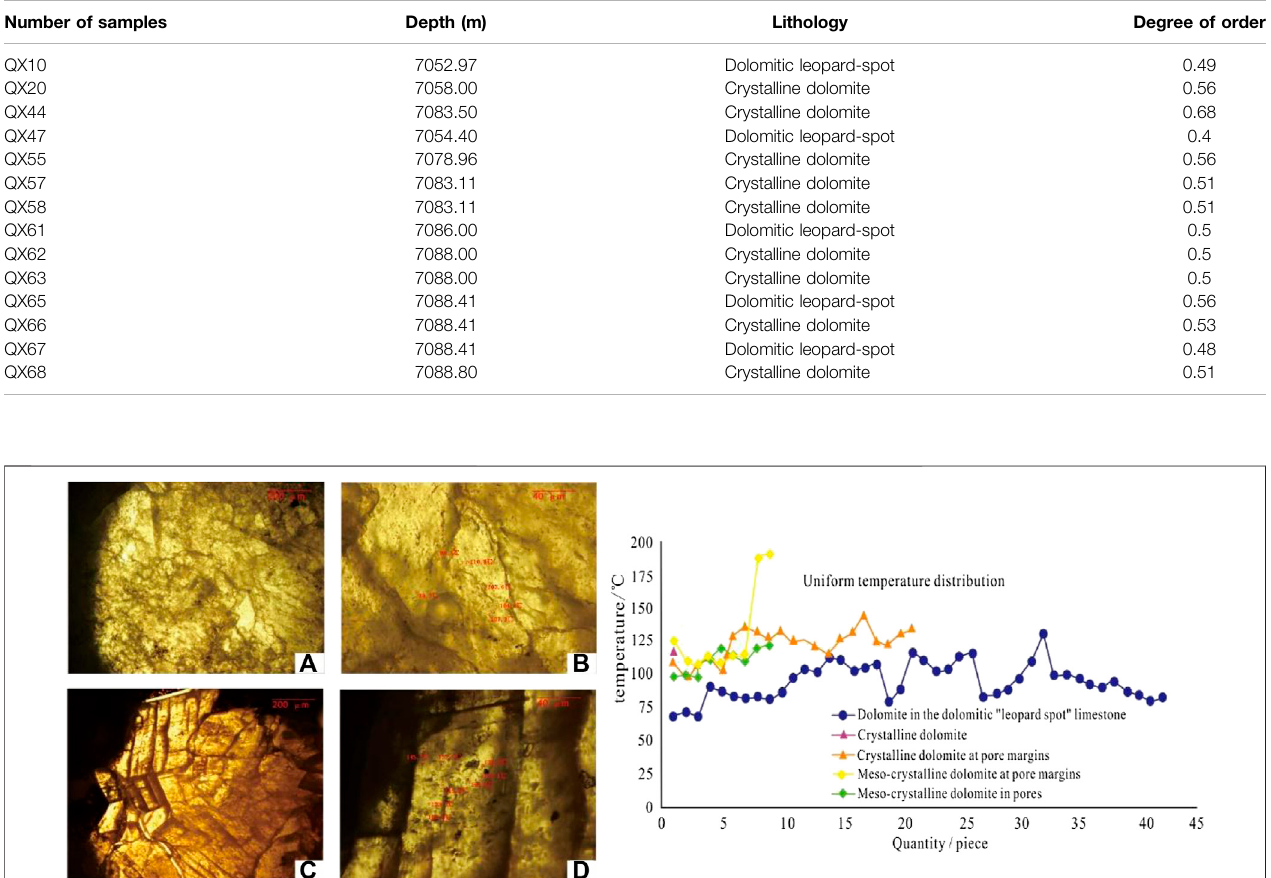
Frontiers in Earth Science |